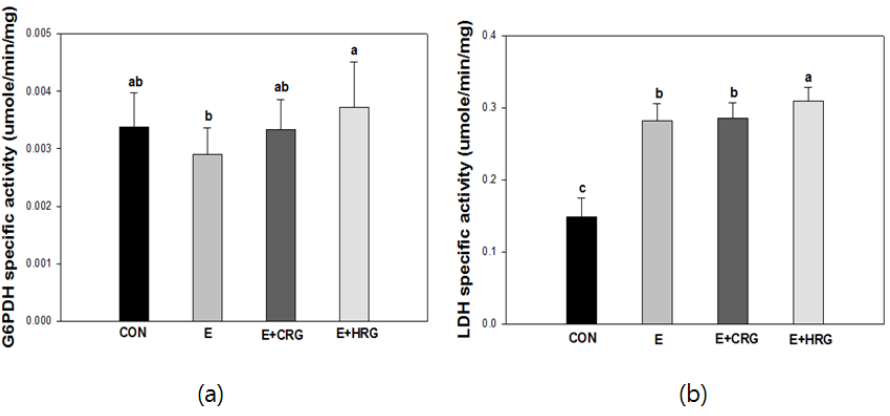
Figure 3. Changes of G6PDH ( a ) and LDH ( b ) enzyme activities in gastrocnemius